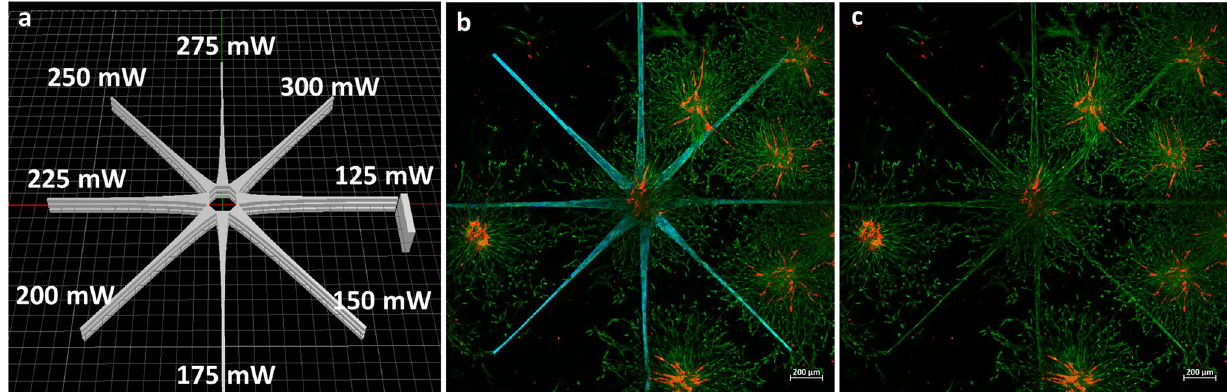
Figure 3. ( a ) Layout of the photografted structure and indication of the different power settings. ( b and c ) Laser scanning microscopy maximum intensity projection (MIP) images of co-culture spheroids of GFP-hASCs and RFP-HUVECs in a 1:1 ratio, encapsulated in a gelatin-based hydrogel. Images were taken on day 3 after photografting. The blue-fluorescent channel is not shown in image ( c ) to better highlight hASCs alignment along the grafted regions. The scale bars represent 500 µm. A time-lapse of GFP-hASC migration over the course of 61 h is shown in Video S1.